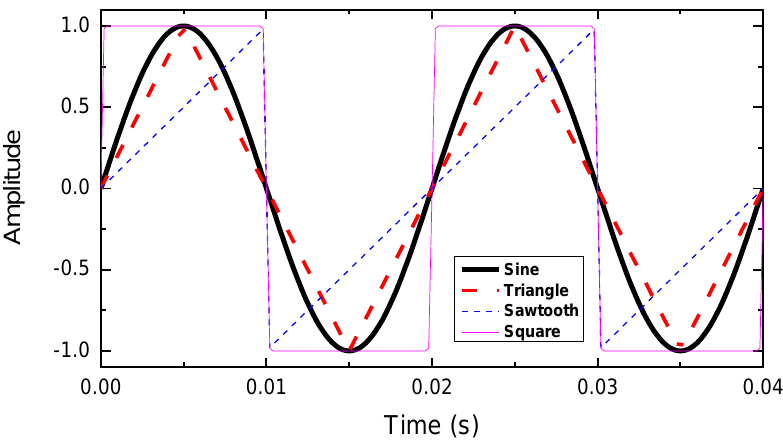
Figure 3. Four oscillating AC signals applied for the magnetic field subject to the HTS tape: sine, triangle, sawtooth and square (modelling signals).